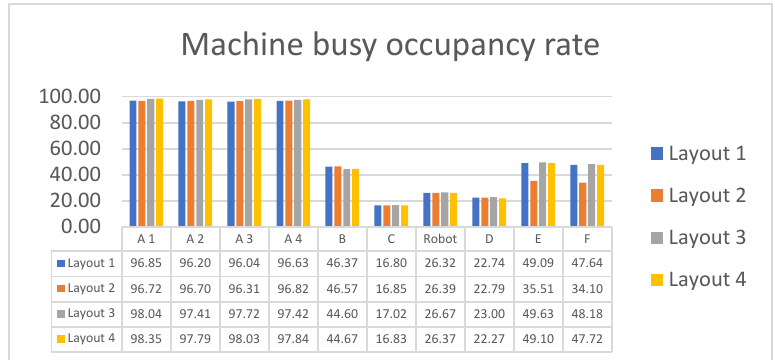
Figure 11. Machine busy occupancy